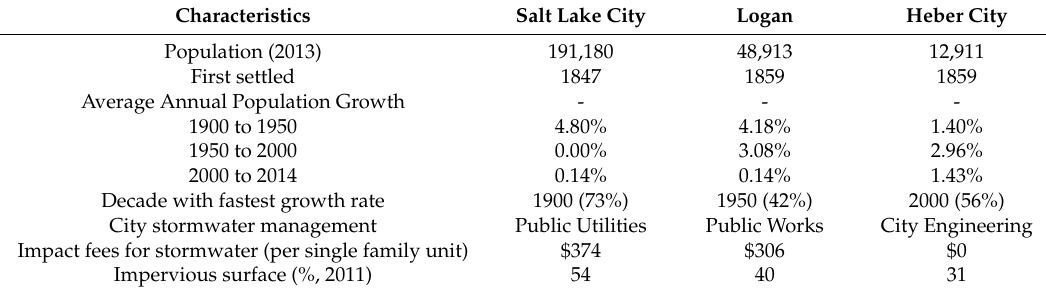
Table 1. Characteristics of three study cities.